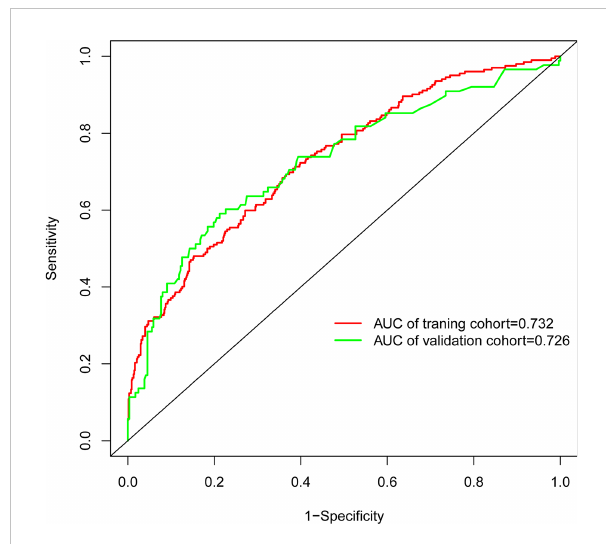
FIGURE 3 The receiver operating characteristic (ROC) curve of POP risk